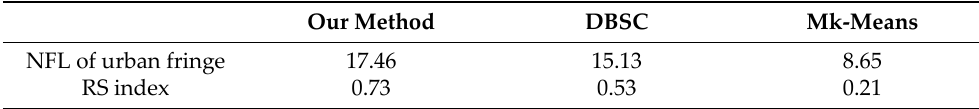
Table 3. NLF of urban fringe areas with various